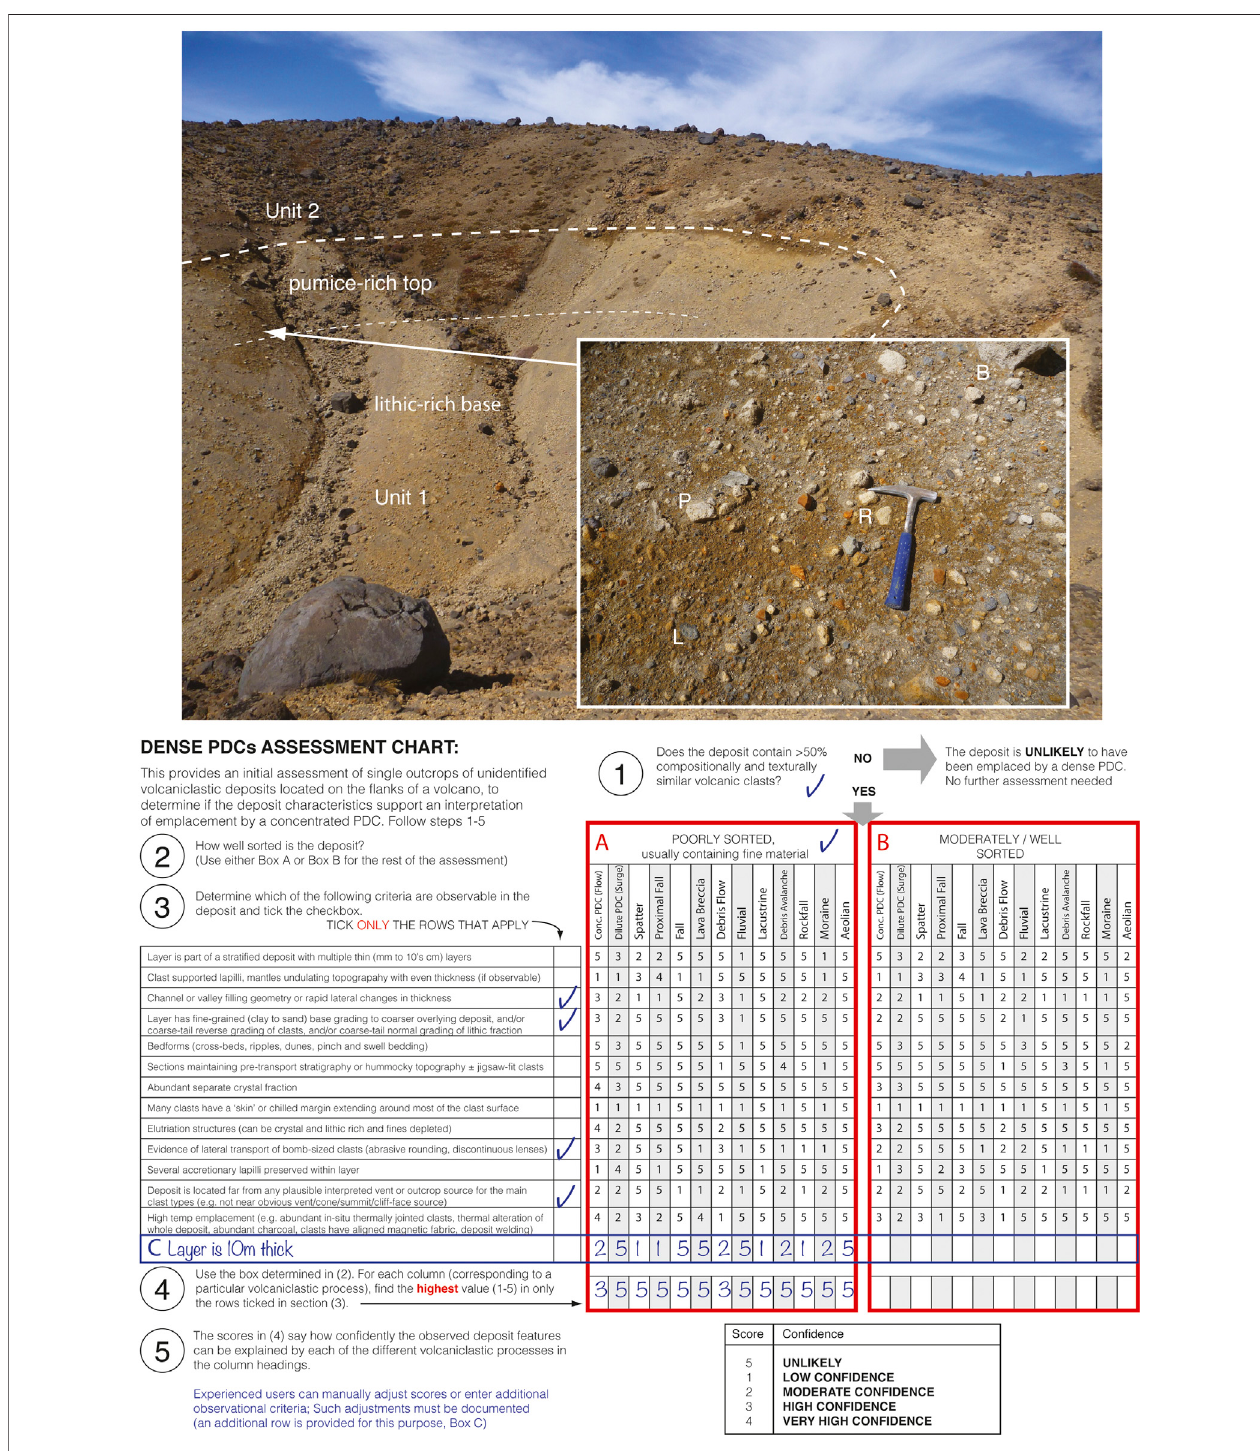
FIGURE4| ExamplevolcaniclasticdepositfromRuapehuvolcano.Thispoorlysorteddepositcontainspumice(P)andlithic(L)clastsina fi ne-grainedmatrix.Many of the pumices are bomb-sized (B) and show signs of abrasive rounding during transport (R). The fi nal con fi dence scores (Step 4) are the highest numbers from the columns above, following the process detailed in Section 5.1 ofthe main text. Here, the scores suggest the observed textures are best attributed to either a debris fl ow or a pyroclastic fl ow, both at “ high con fi dence. ” Note the manual addition of an additional assessment criteria (deposit thickness) and associated user-generated indicative scores in Box C. This demonstrates how more experienced users can modify the scheme in light of their own observations; in this case helping to eliminate surge and fl uvial deposits from the interpretation.